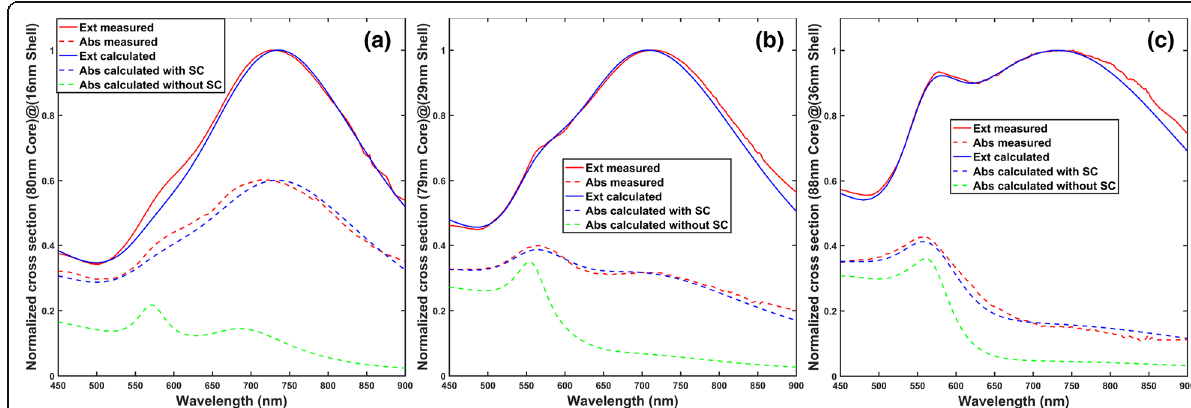
Fig. 4 Comparisons between measured and calculated absorption spectrums with and without consideration of surface scattering of conduction electrons. All calculations are carried out by Mie theory. The surrounding medium is PVA (polyvinyl alcohol) having a refractive index of 1.5. Note that the surrounding medium of nanoshells in our experiment (PVA, n =1.5) is different from that in the characterization sheet provided in the supporting information, which is water. The surfactants coating the nanoshells can be neglected because the surfactants are thin polymer and have similar refractive index as the surrounding medium of PVA. The refractive index of silica is assumed to be 1.45 in the calculations. Gold ’ s dielectric constants without surface scattering are from reference [38], while those with surface scattering are given by Eqs. (1) and (4). In all figure legends, “ Ext ” is short for extinction, “ Abs ” is short for absorption, and “ SC ” is short for surface scattering. In each figure, “ Ext calculated ” and “ Abs calculated with SC ” are the extinction and absorption spectrums calculated with the fitting parameters shown in Table 2, while “ Abs calculated without SC ” is the absorption cross section calculated without considering size distribution and surface